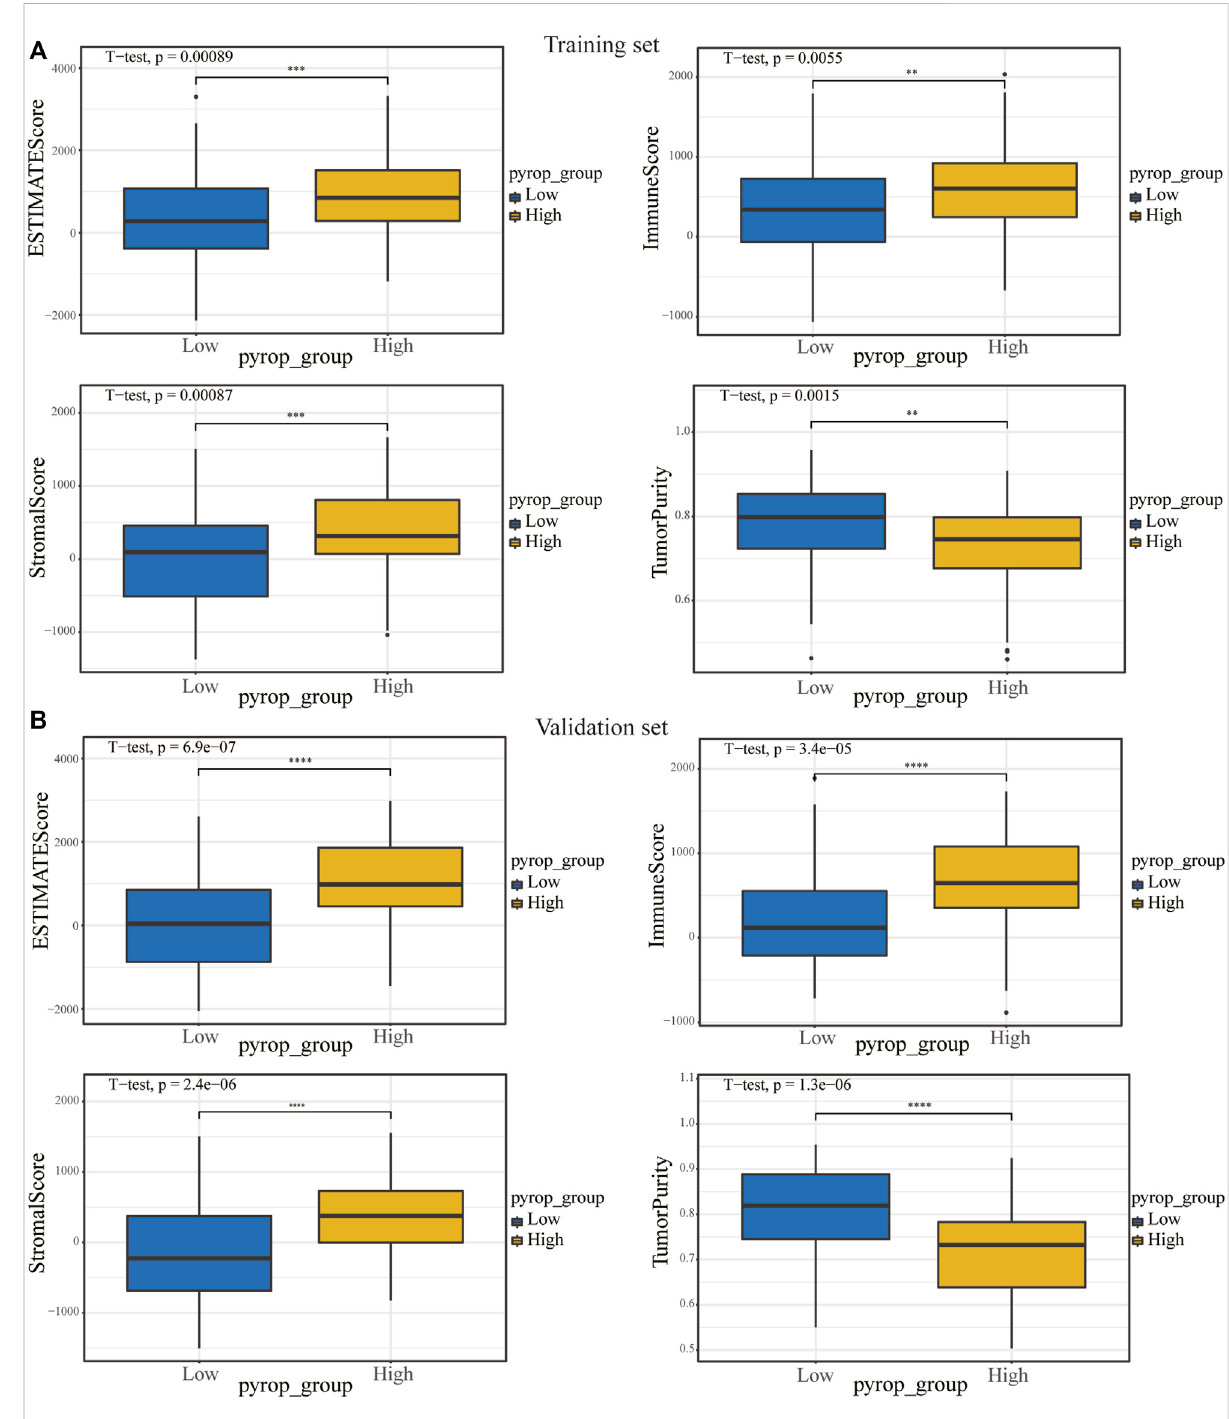
FIGURE 9 The relationship between pyroptosis scoring and immune score. (A) In the training set, the effect of pyroptosis scoring on ESTIMATEScore, ImmuneScore,StromalScore,andTumorPurity. (B) DifferencesinESTIMATEScore,ImmuneScore,StromalScoreandTumorPuritybetween different pyroptosis scoring groups in the validation set. ** p < .01; *** p < .001; **** p <